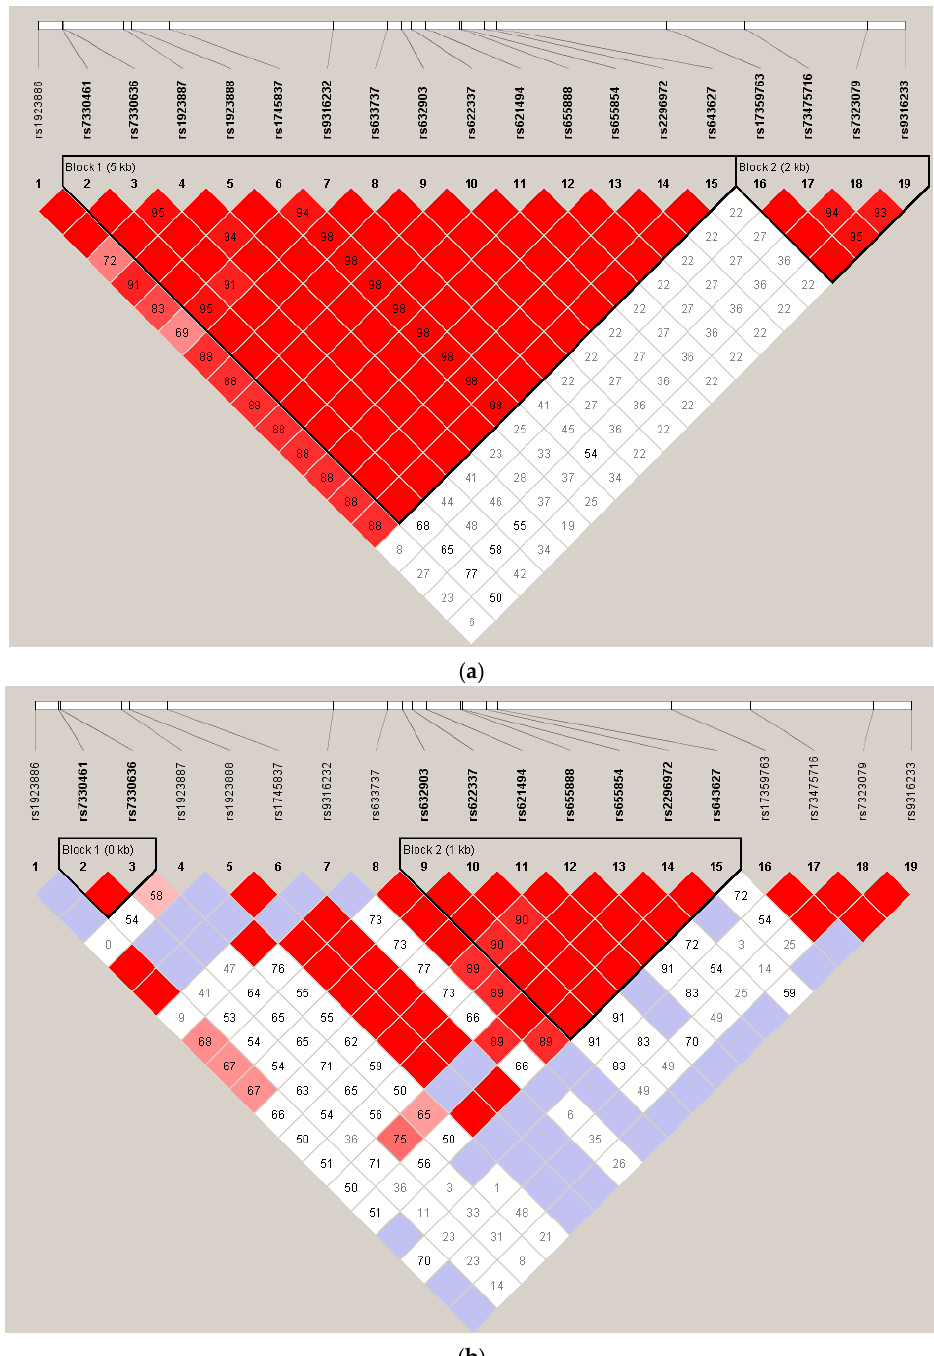
Figure 4. Linkage disequilibrium plots of rs733046 in HTR2A in Caucasian and African American patients. ( a ) Caucasian patients. ( b ) African American patients. The linkage disequilibrium (LD) plots were created using Haploview, and the color code on the plot follows the standard color scheme for Haploview: white = (|D ′ | < 1, logarithm (base 10) of odds (LOD) < 2), shades of pink/red = (|D ′ | < 1, LOD ≥ 2), blue = (|D ′ | = 1, LOD < 2), bright red = (|D ′ | = 1, LOD ≥ 2). Numbers on top of the plot are the reference sequence ID (rs-number) of the included single nucleotide polymorphisms (SNPs) with the distance between them indicated on the white bar above.